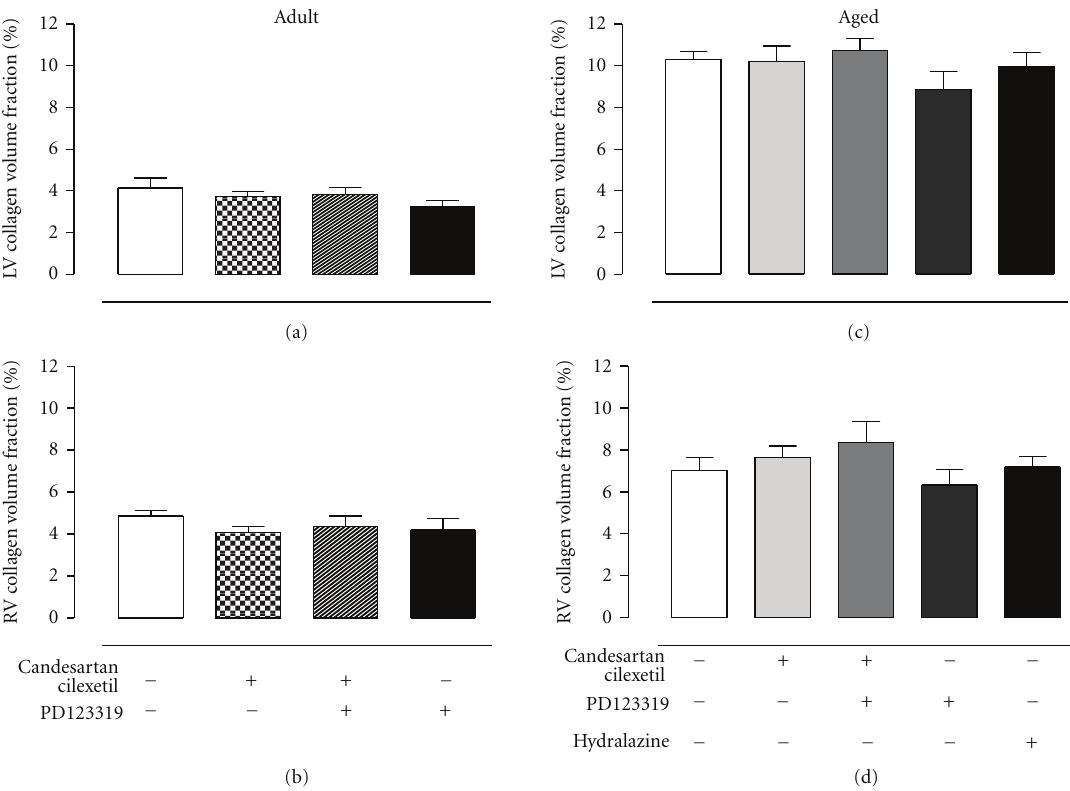
Figure 4: Mean data of interstitial collagen volume fraction of (a) left and (b) right ventricles of adult SHRs treated with vehicle (control, n = 6), candesartan cilexetil (2mg/kg/day) alone ( n = 7) or in combination with PD123319 (10mg/kg/day, n = 7) or PD123319 alone. Interstitial collagen volume fraction of (c) left and (d) right ventricles of senescent SHRs treated with vehicle (control, n = 10), candesartan cilexetil alone ( n = 9) or in combination with PD123319 ( n = 9), PD123319 alone ( n = 4), or hydralazine (30mg/kg/day, n =